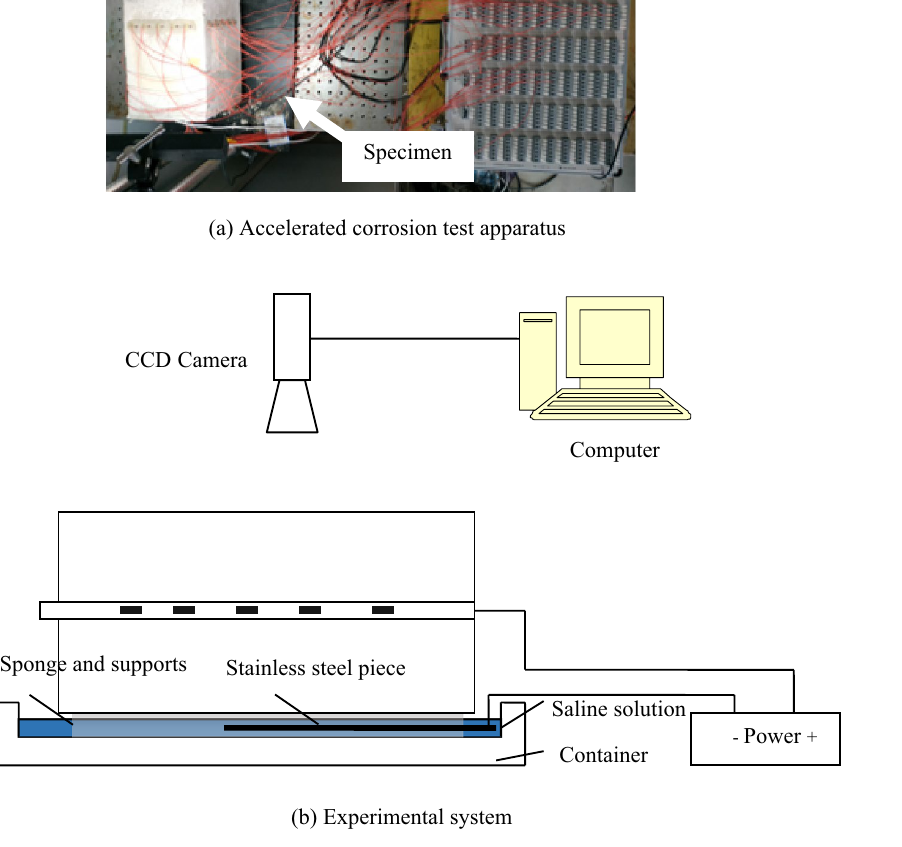
Figure 7. Experimental measurement